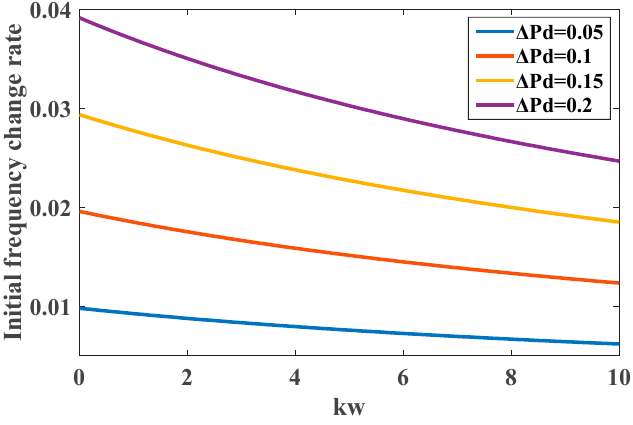
Figure 3. Curves of initial frequency change rate (IFCR) under different parameter k w .